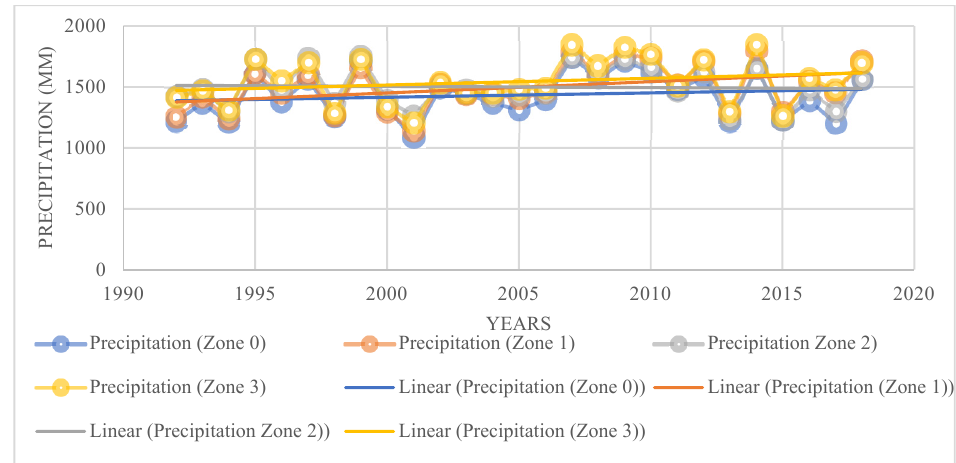
Figure 10. Regression model for yearly total precipitation based on combined nighttime light population density-based urban development zone over study area. Table 10. Linear Regression Results When Combined Criteria are